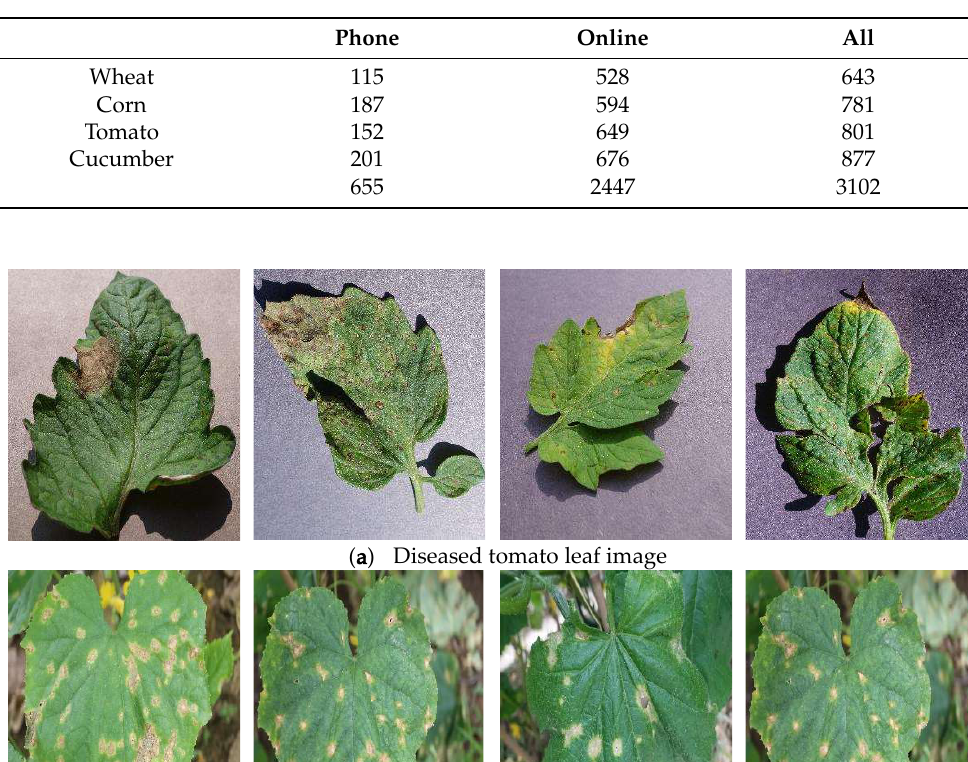
Table 1. Statistics on the number of images.